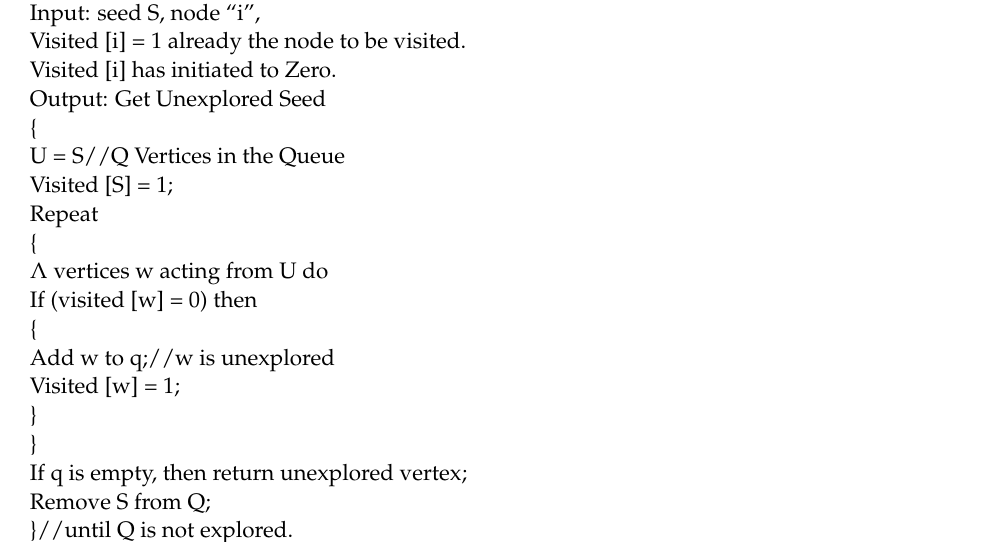
Algorithm 1 : Explored the nodes by breadth-first